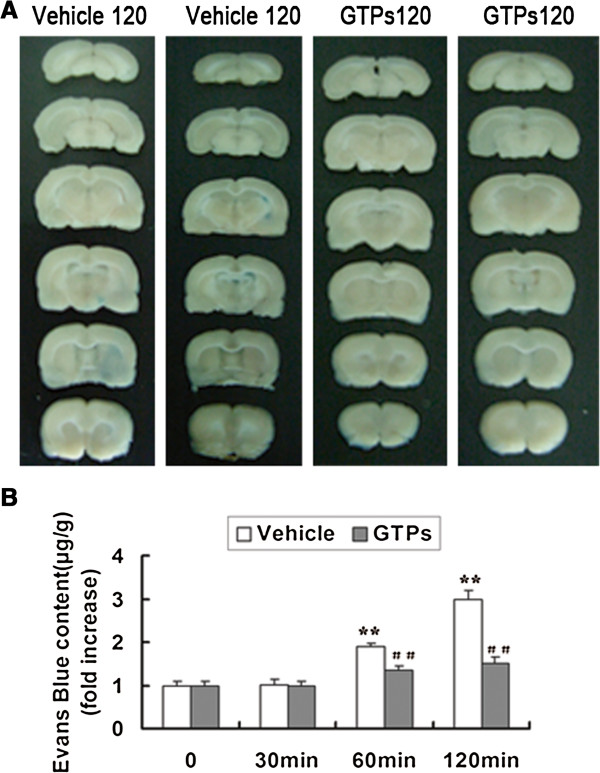
Effects of GTPs on BBB permeability at the early stage of cerebral ischemia were assessed by Evans blue dye leakage. Experiment groups are saline-treated (vehicle) groups and GTPs-treated groups at the time points of 0, 30, 60, and 120 min after ischemia, respectively. (A) representative images of brain sections in the groups of ischemia and GTPs-treated groups of ischemia at 120 min. (B) Evans blue content is expressed as a fold increase relative to the vehicle group of ischemia at 0 min. Data are given as the means ± SD (n = 8, each). **P < 0.01 vs. vehicle group of ischemia 0 min. ##P < 0.01 vs. vehicle group at the same time points.